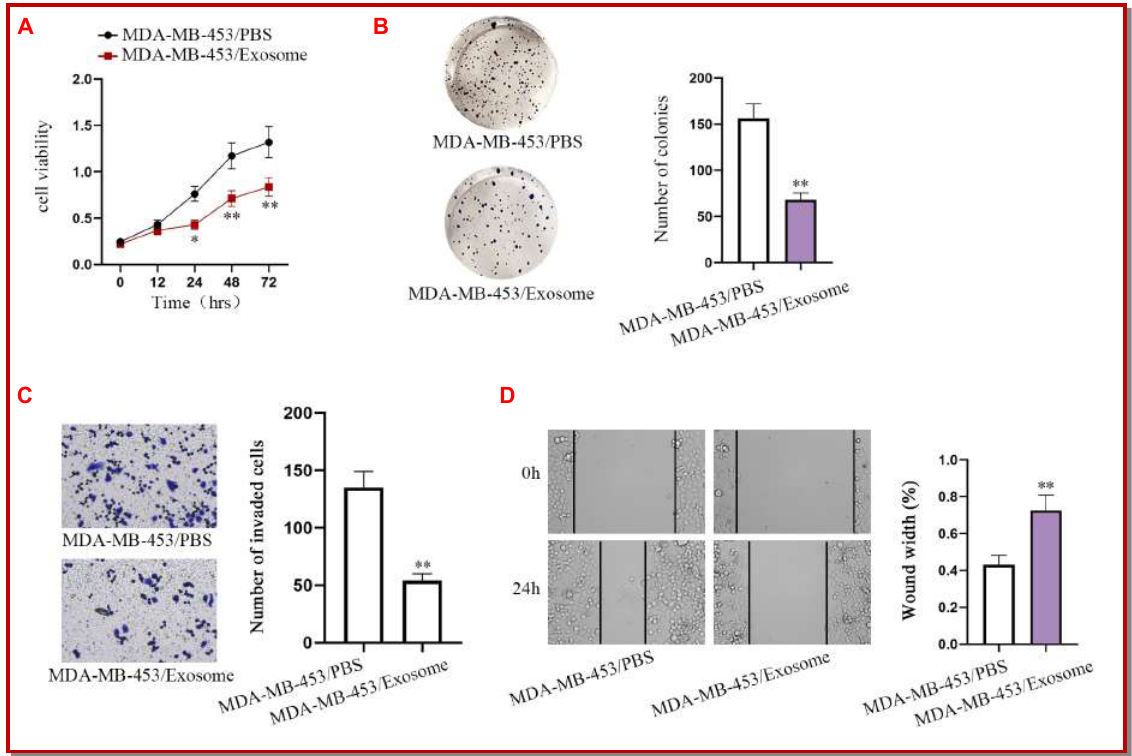
Figure 2: Exosomes derived from zoledronic acid-treated MDA-MB-453 cells suppressed the migration of breast cancer cells. Cell viability was detected by MTT assay (A). The number of colonies was detected by the colon formation assay (B). The number of migrated cells was detected by transwell assay (C). The wound width was detected by wound healing assay (D) (p<0.05,